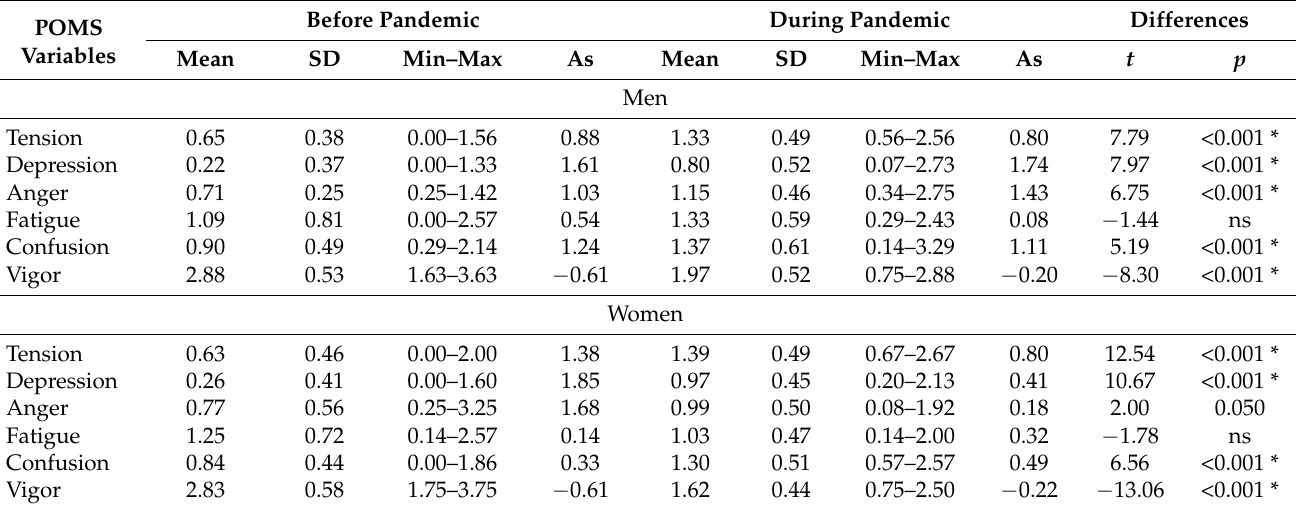
Table 2. Descriptive statistics and differences in the mean values of the POMS parameters in men (N = 30) and women (N = 30) before and during the COVID-19